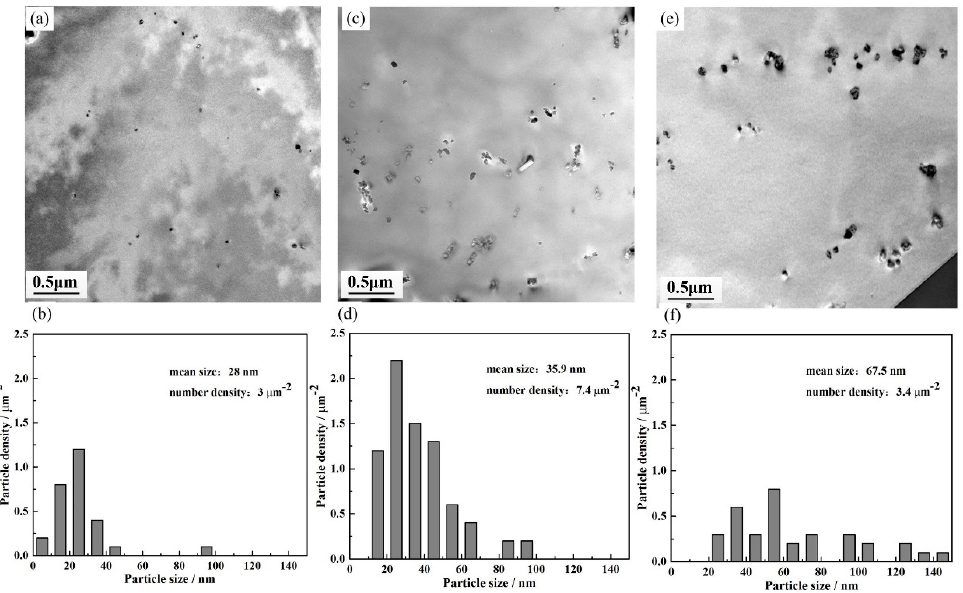
Figure 2. Precipitates micrographs ( a , c , e ) by TEM and size and distribution of precipitates ( b , d , f ) in the intermediate sheets annealed at 1000 °C for 15 min ( a , b ), 2 h ( c , d ), and 20 h ( e , f ).